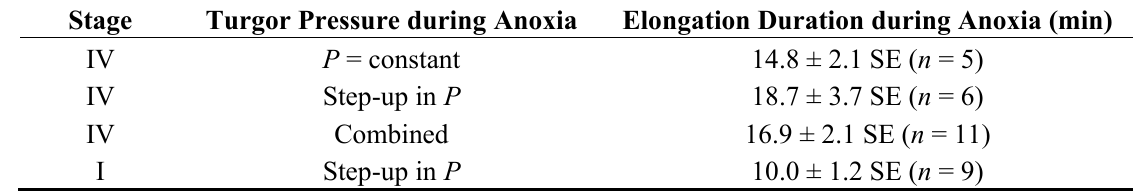
Table 1. Duration of elongation growth during anoxia for Stage IV and Stage I